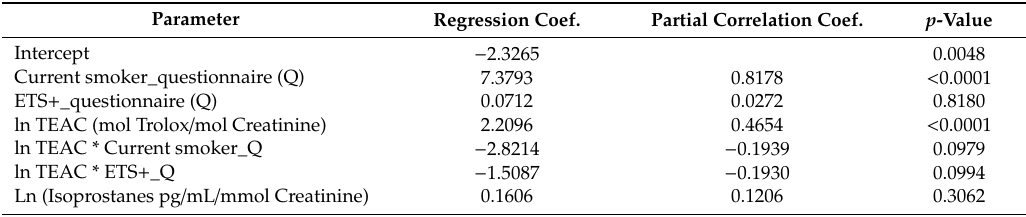
Table 7. Multiple linear regression modeling of transformed cotinine